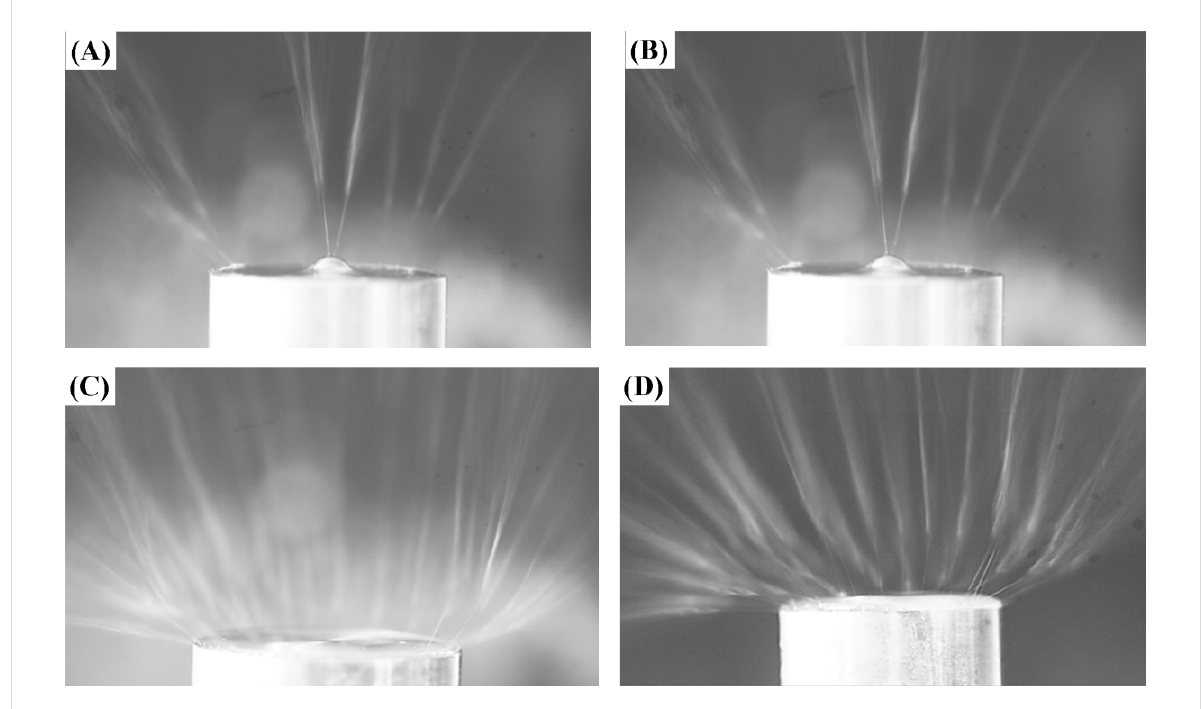
Figure 3: Photographs of the MBE (A), MFSE (B), OSFSE (C) and SSFSE (D) process.